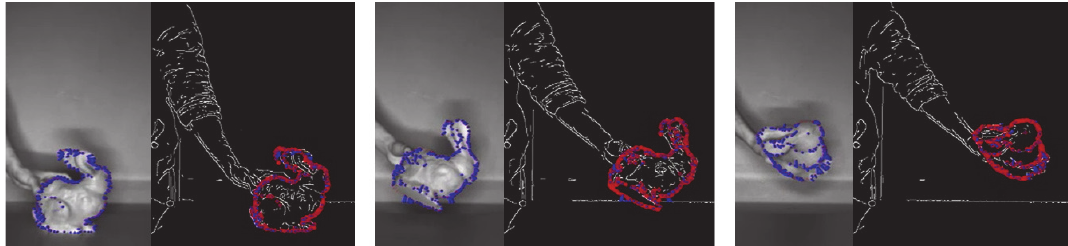
Figure 6: Edge-based 3D tracking.